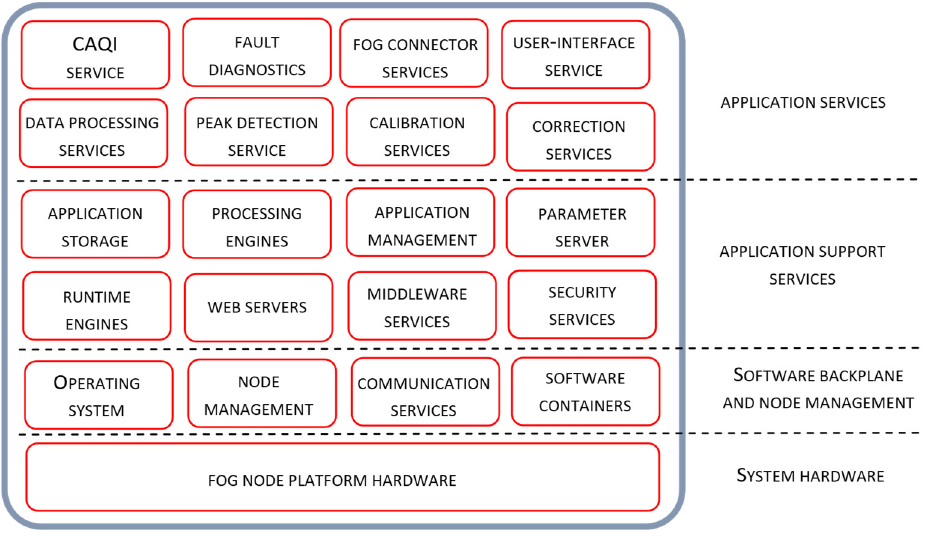
Figure 3. Tier 1 fog node software architecture view.